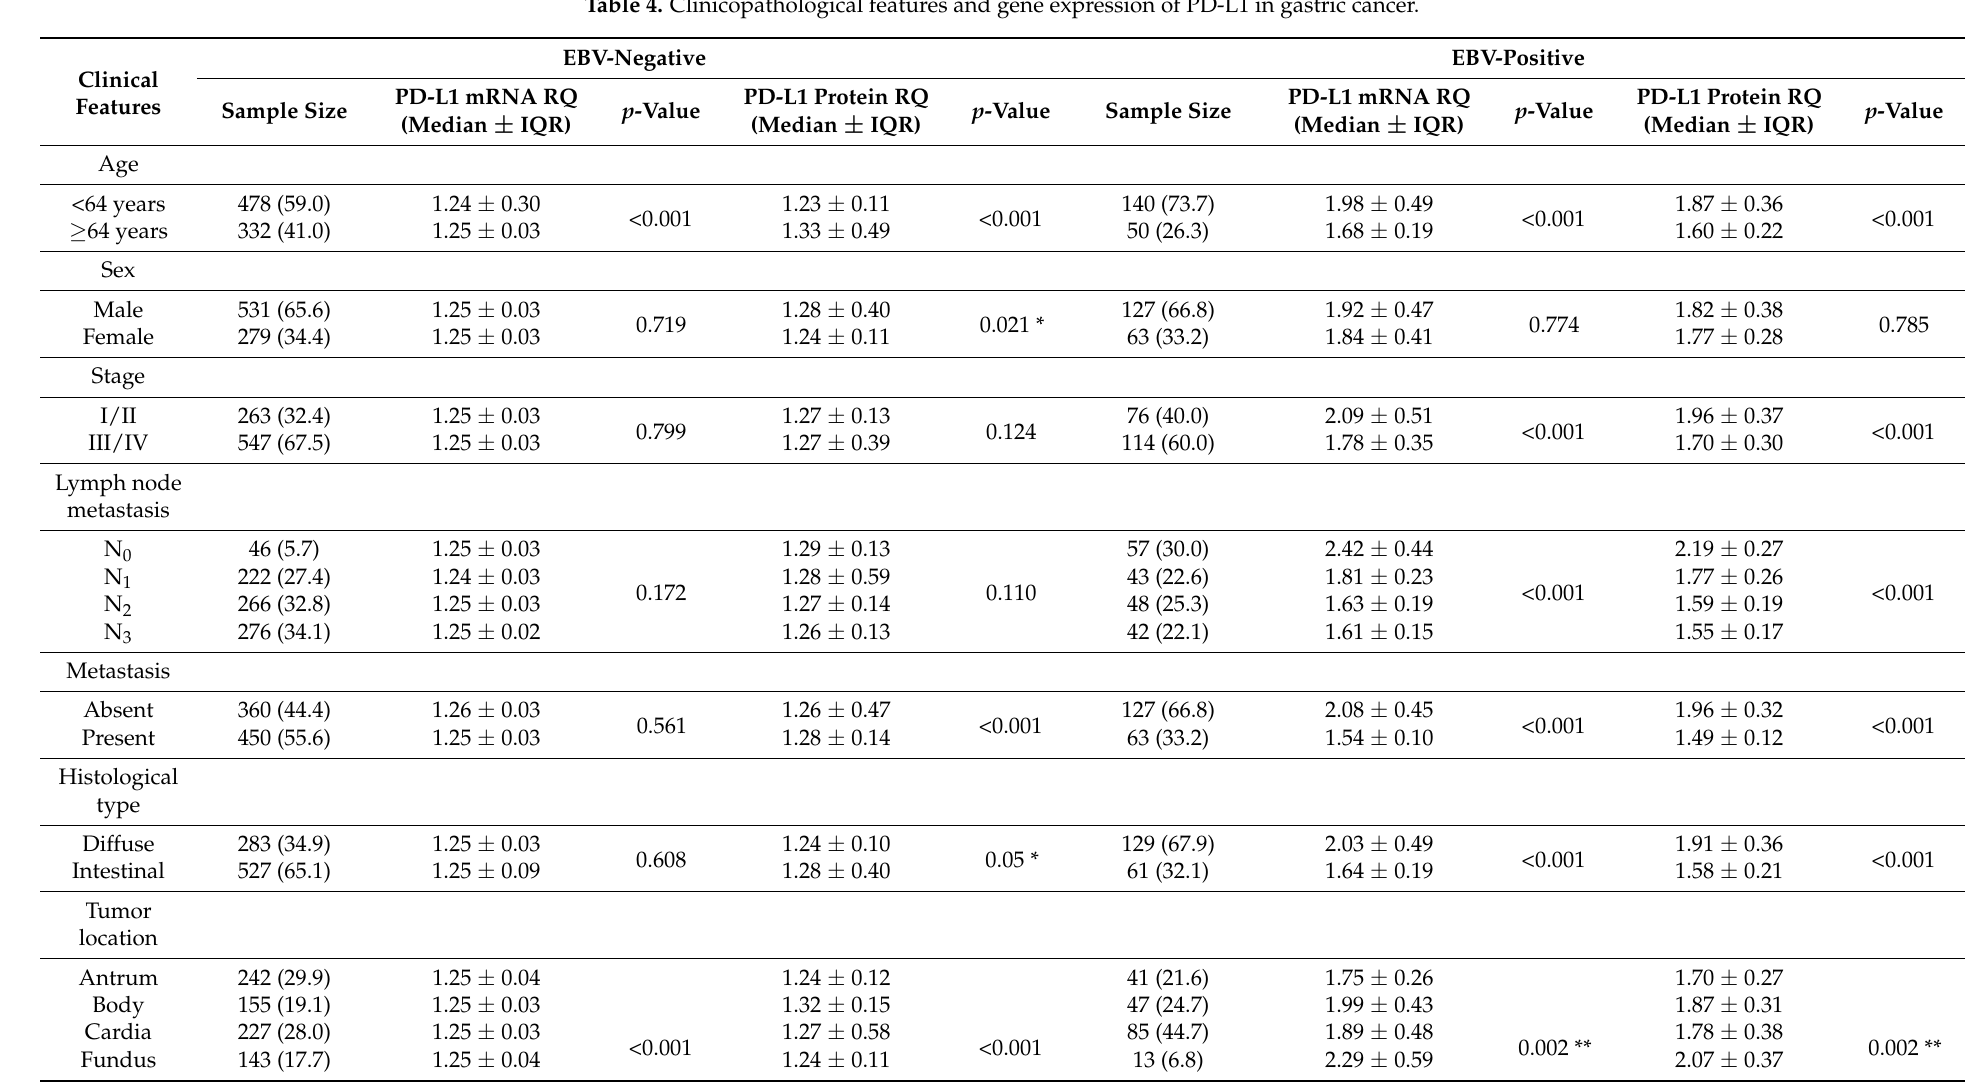
Table 4. Clinicopathological features and gene expression of PD-L1 in gastric